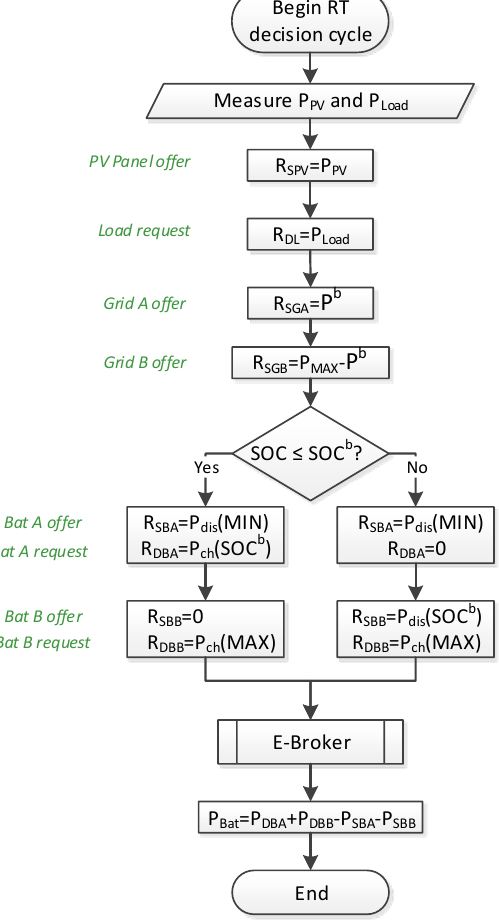
Figure 3. Flow chart of the real time (RT) decision cycle. Power requests are detailed.